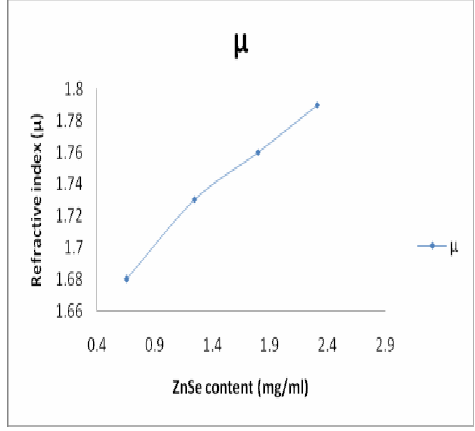
Figure 6 : Refractive index profile of ZnSe/PVA with varying Zn 2+